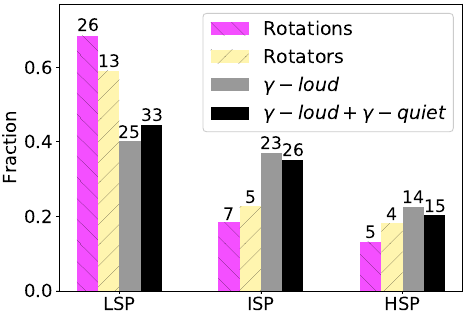
Figure 6. Occurrence of rotations and rotators (sources exhibiting rotations) among blazars of different synchrotron peak position class. Numbers correspond to the number of blazars (the number of events in the case of rotations) in each class. Based on data from